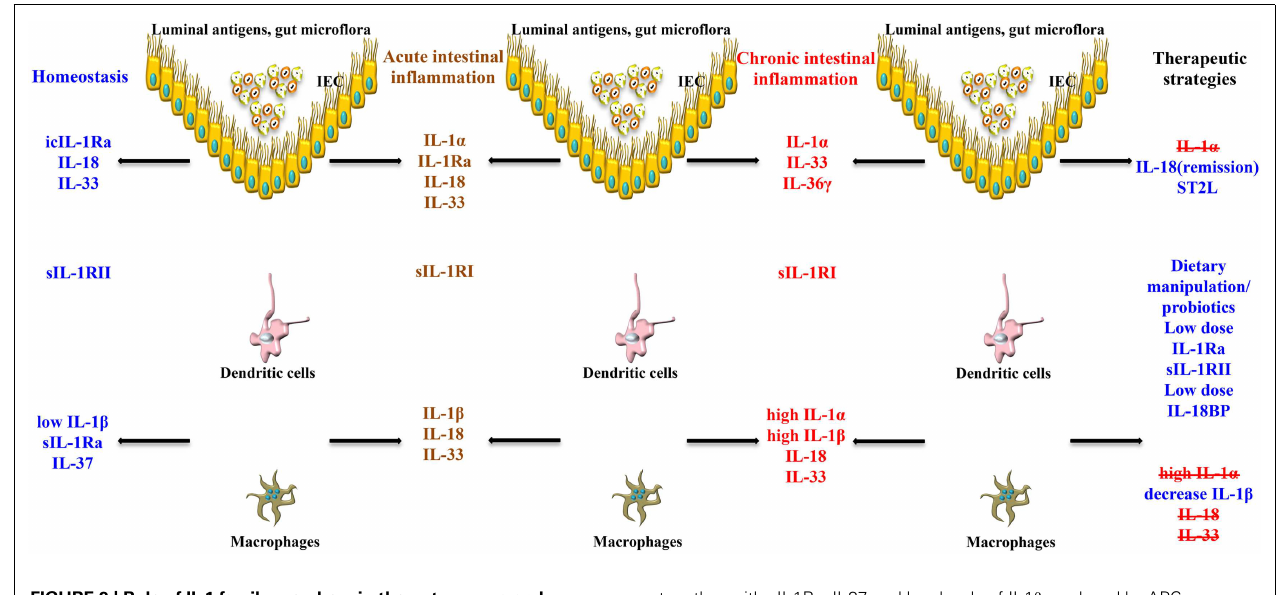
FIGURE 3 | Role of IL-1 family members in the gut mucosa and potential therapeutic strategies to restore intestinal homeostasis . The effects of the same IL-1 family member can vary, and are often dichotomous, depending on the cell source, phase of disease (early vs. late), and inflammatory state (acute vs. chronic) of the host. IECs and APCs are critically involved in maintaining gut homeostasis, but also in triggering gut inflammation. icIL-1Ra, IL-18, and IL-33 released by IECs,